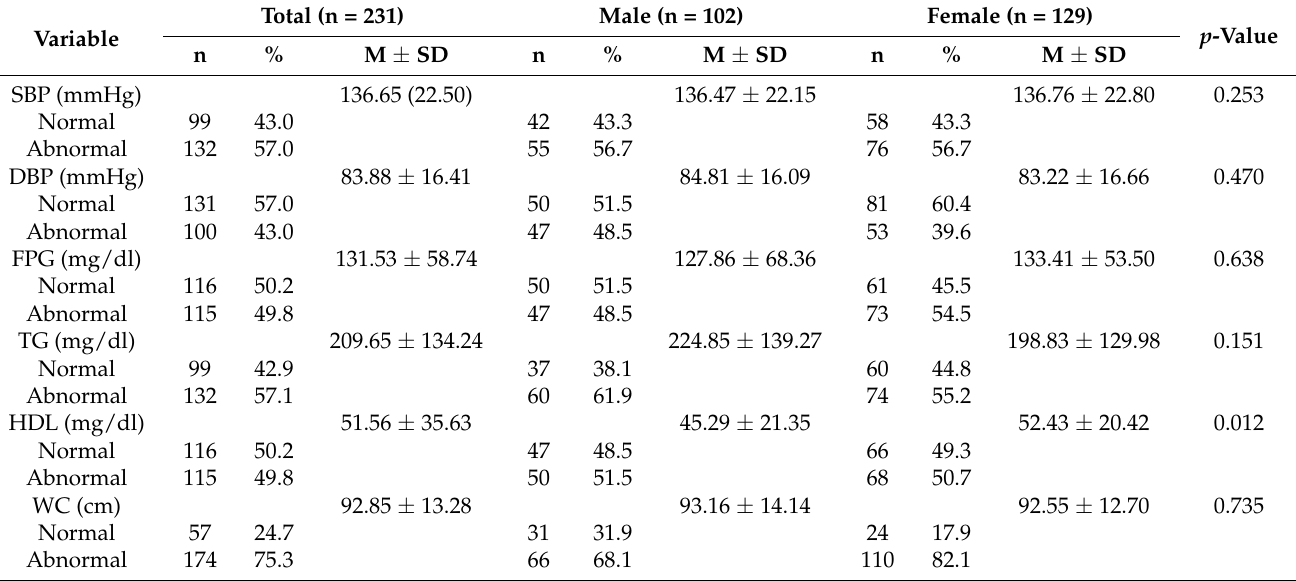
Table 2. MetS-related indicators (n = 231).